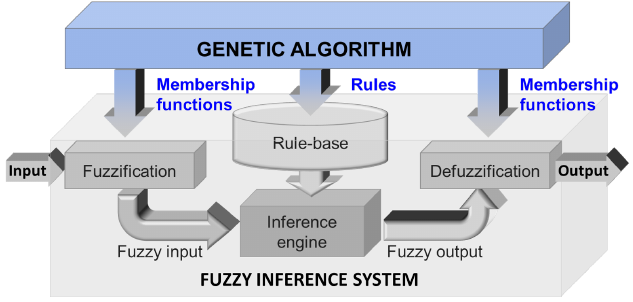
Figure 1. Concept of the genetic fuzzy